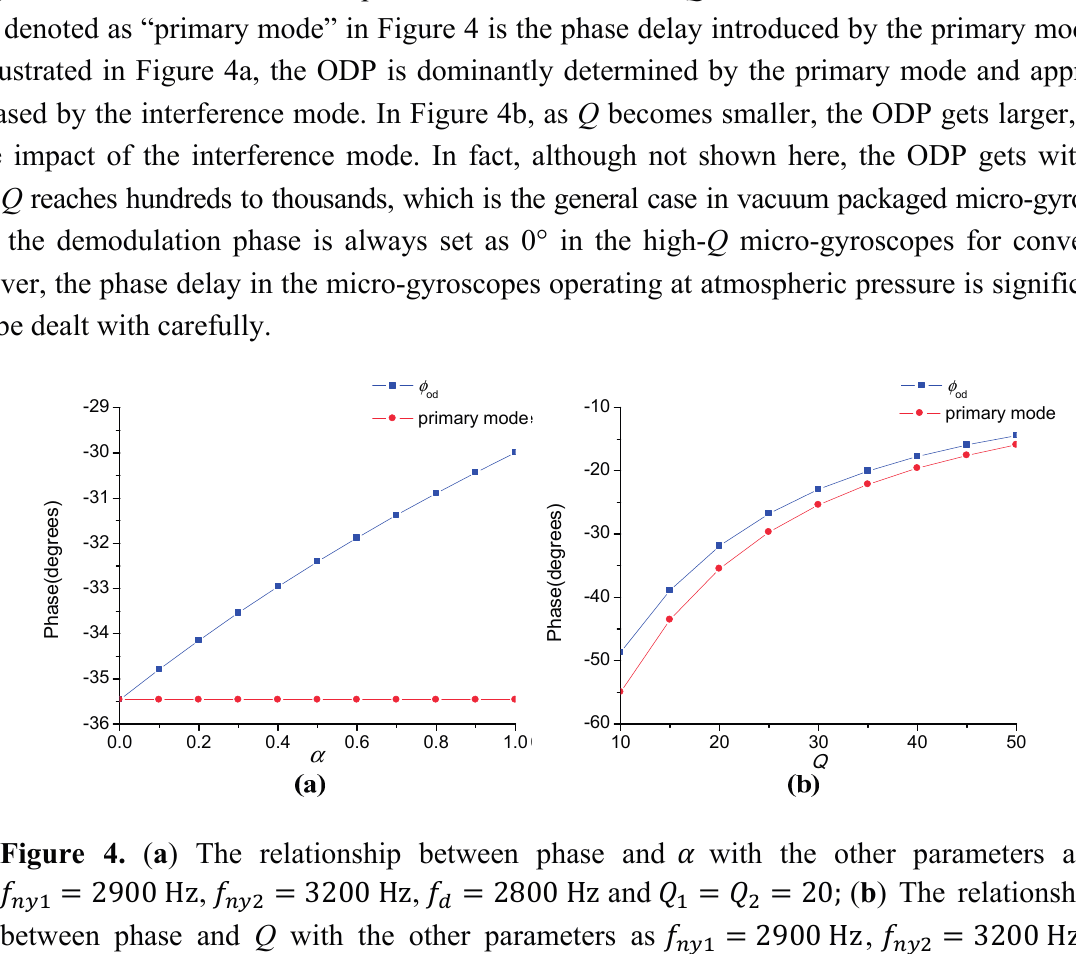
= (cid:1843) = 20; ( b ) The relationship (cid:2869) (cid:2870) = 2900 Hz , (cid:1858) = 3200 Hz , (cid:3041)(cid:3052)(cid:2869) (cid:3041)(cid:3052)(cid:2870)